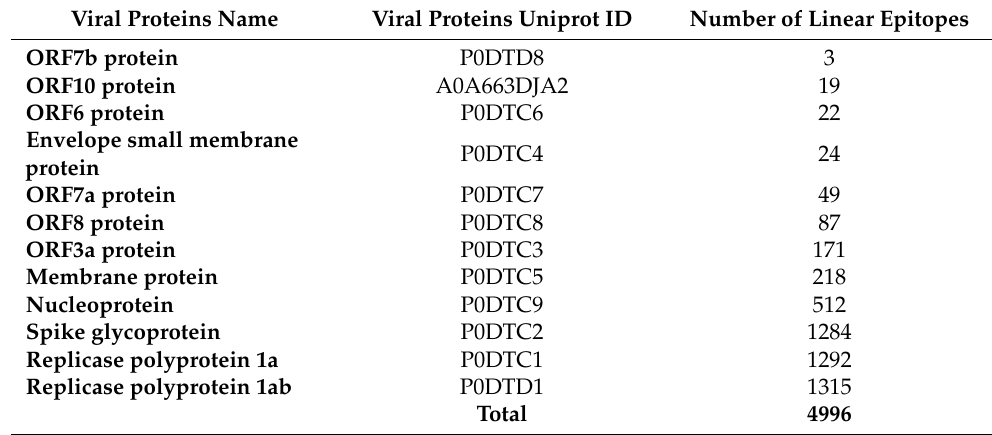
Table 2. Number of linear epitopes collected that recognize SARS-CoV-2 immunogenic viral proteins.